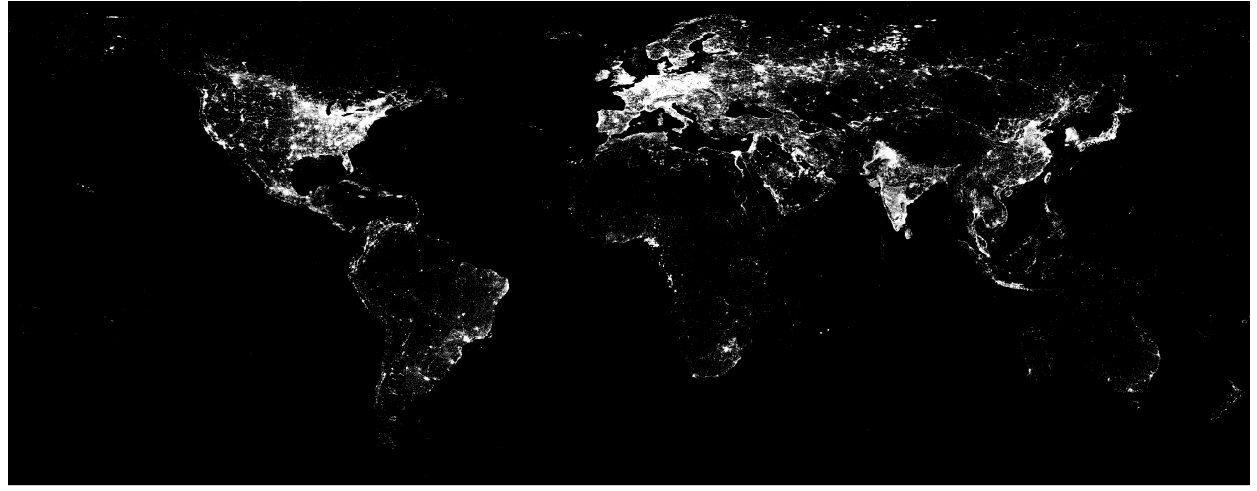
Figure 3. Global DMSP/OLS nighttime light in 2010 (by